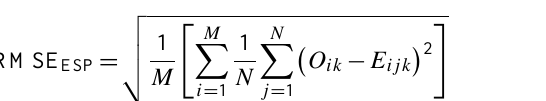
time κ . RMSE ESP is